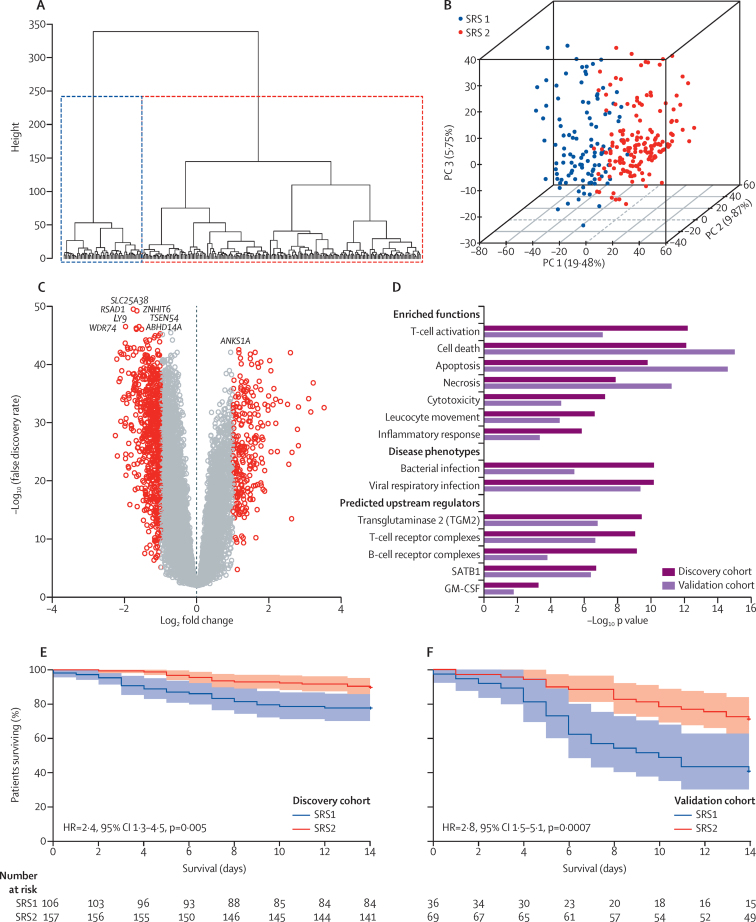
Transcriptomic sepsis response signaturesUnsupervised hierarchical cluster analysis for the top 10% most variable probes (n=2619) for the 265 patients in the discovery cohort (A). First three PCs plotted with the proportion of variance explained by each component (B); individuals are coloured by group membership based on two groups assigned with k-means. Volcano plot (C) of differentially expressed probes for SRS1 versus SRS2 (red colouring shows fold change >1·5, false discovery rate <0·05). Most enriched functions, disease phenotypes, and predicted upstream regulators were derived from differentially expressed genes (D). Kaplan-Meier survival plot by SRS group (95% CIs shaded) for (E) discovery cohort and (F) validation cohort. SRS=sepsis response group. PC=principal component.